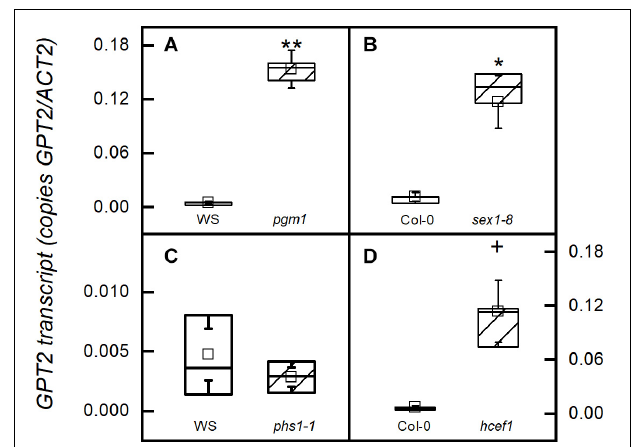
FIGURE 1 | GPT2 expression in starch related mutants. All samples were taken from plants in growth conditions, PFD 120 µ mol m − 2 s − 1 and 400 ppm CO 2 . Transcripts were measured in (A) a starchless mutant ( pgm1-1 ), (B) a starch excess mutant ( sex1-8 ) that cannot degrade starch, (C) a starch phosphorylase knock out ( phs1-1 ) that cannot carry out phosphorolytic starch degradation, and (D) a chloroplastic FBPase mutant ( hcef1 ). ∗ α = 0.05; ∗∗ α = 0.01; + α = 0.1, n =